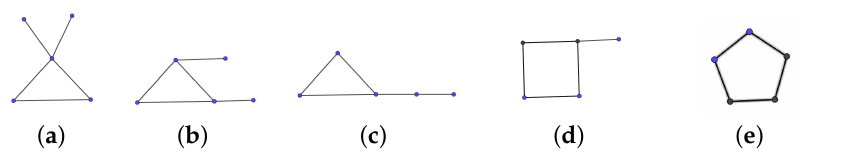
Figure 2. All unicyclic graphs of order 5, in which ( a ), ( b ) and ( c ) have the cycle length three, and ( d ) and ( e ) have the cycle length four and five, respectively.